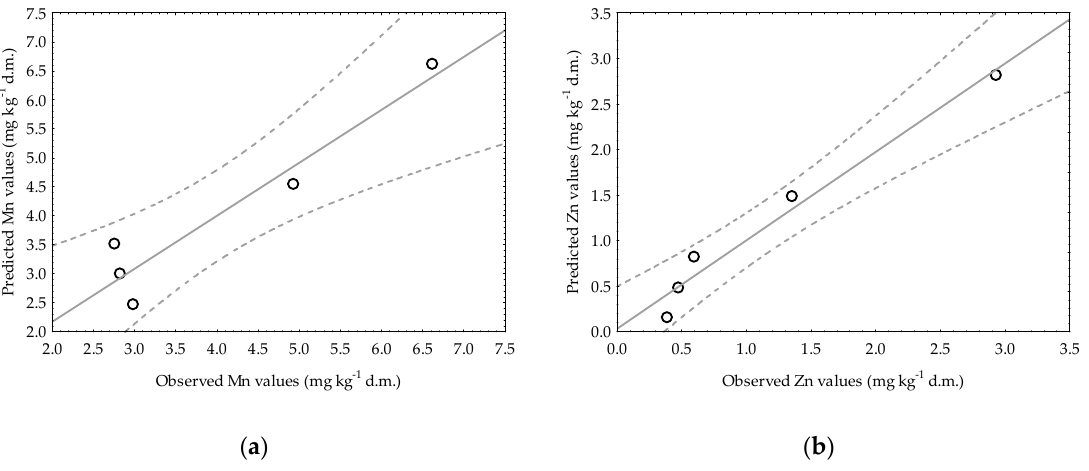
Figure 5. Observed versus predicted plots of linear regression models for Mn ( a ) and Zn ( b ) content sion model fits the data reasonably well and much better than that of Mn. changes over time in very light soil for SI + B treatment; these experimental combinations were chosen because they had the highest R 2 values (R 2 = 0.9139 for Mn and R 2 = 0.9706 for Zn).